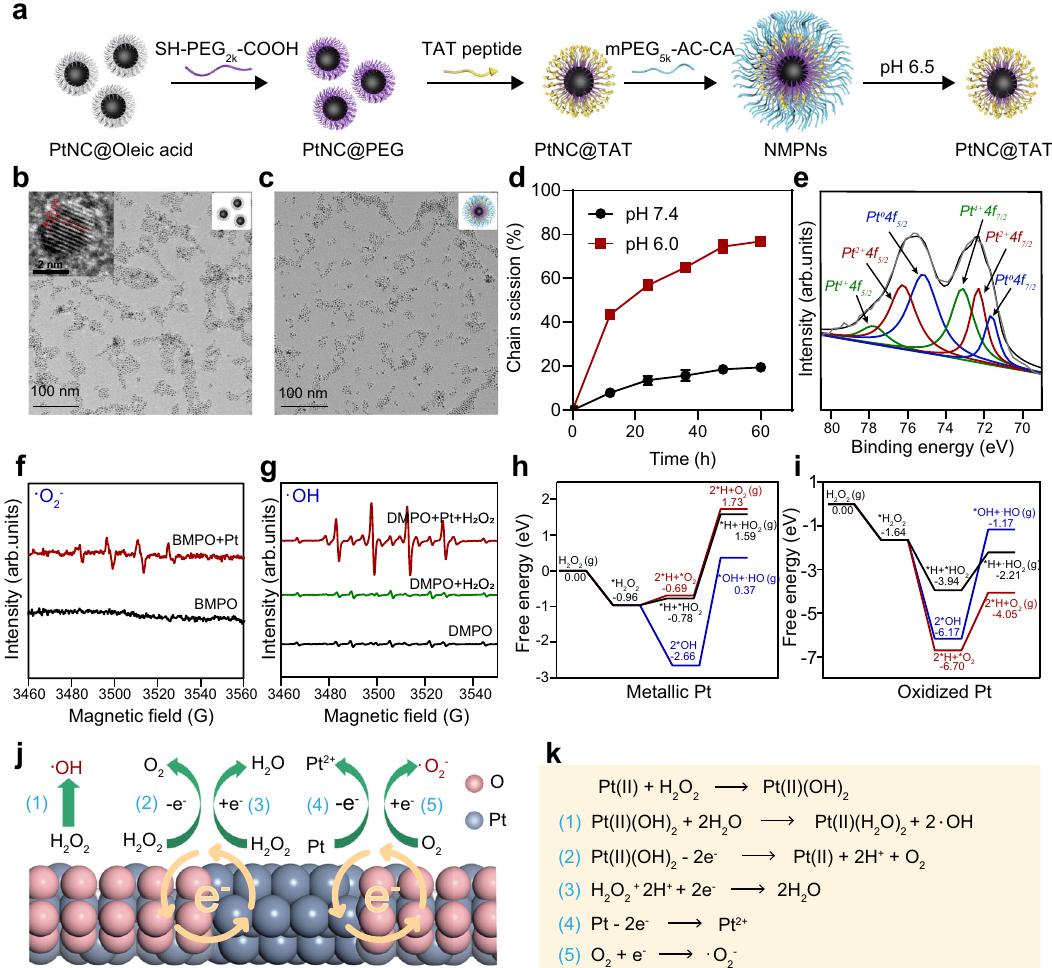
Fig. 2 | Designed synthesis and characterization of NMPNs with high perfor- mance catalytic activity. a Schematic diagram of the synthesis of NMPNs. b Representative TEM image of PtNCs in chloroform. Scale bar: 100nm; Insert: high-resolution TEM image of PtNCs. Scale bar: 2nm. n =3 independent experi- ments. c TEM image of NMPNs in water. Scale bar: 100nm. n =3 independent experiments. d The analysis of shedding behaviour of mPEG 5K -AC-CA from the surface of NMPNs at pH 6.5 and 7.4. Rhodamine B isothiocyanate (RITC) was con- jugated to the terminal of mPEG 5K -AC-CA to obtain RITC-mPEG 5K -AC-CA, and the fl uorescence intensity of RITC-mPEG 5K -AC-CA fragments released from